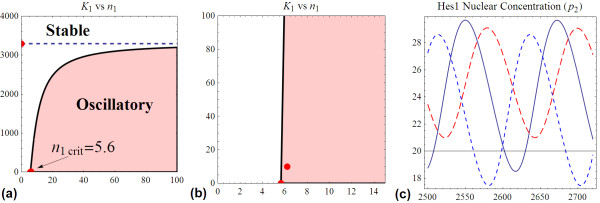
The Hes1 oscillator. (a) Two-parameter K1-n1 bifurcation diagram for the Hes1 oscillator. (b) Close-in of the bifurcation diagram with Zeiser et al.'s point highlighted in red. (c) Temporal revolution of Hes1 nuclear concentration (p2) for three feedback strengths: K1 = 10 (black, solid); K1 = 0.1 (blue, dot) and K1 = 100 (red, dash).